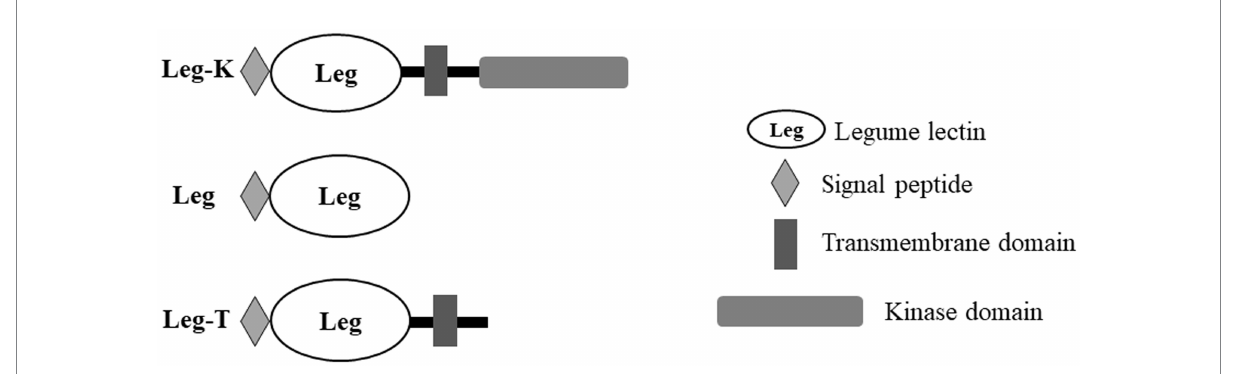
FIGURE 3 Schematic overview of the domain architecture in